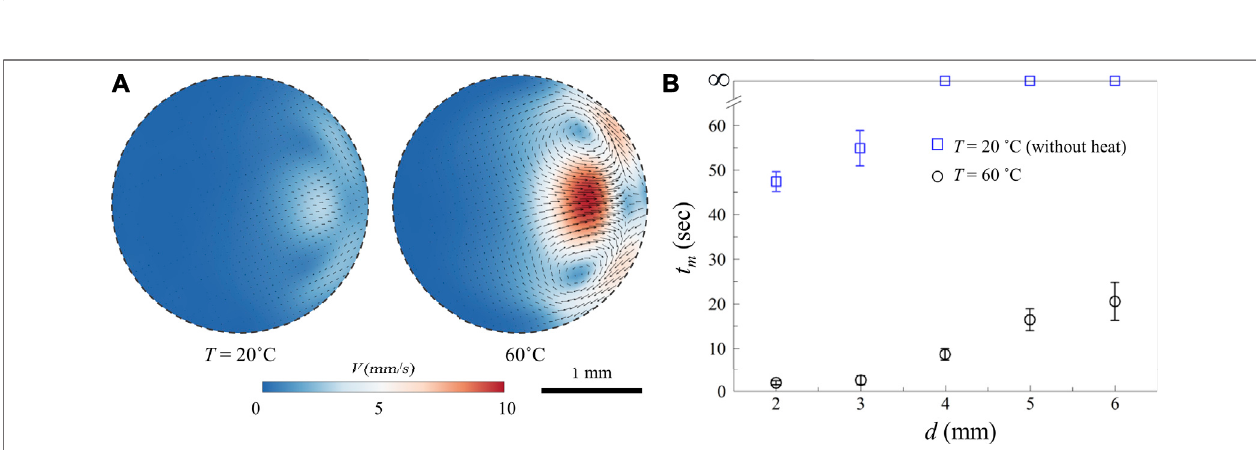
FIGURE 8 | (A) PIV results for the acetone vapor-mediated solutal Marangoni fl ow fi elds formed in the pure DI water droplet with the distance between the sessile dropletandmicrochanneltipof d (cid:2) 4 mmat T (cid:2) 20 ° C (left) and60 ° C (right) . (B) Thetimerequiredforcompletedropletmixing( t m )asafunctionof d at T (cid:2) 20 ° C(blue)and 60 ° C